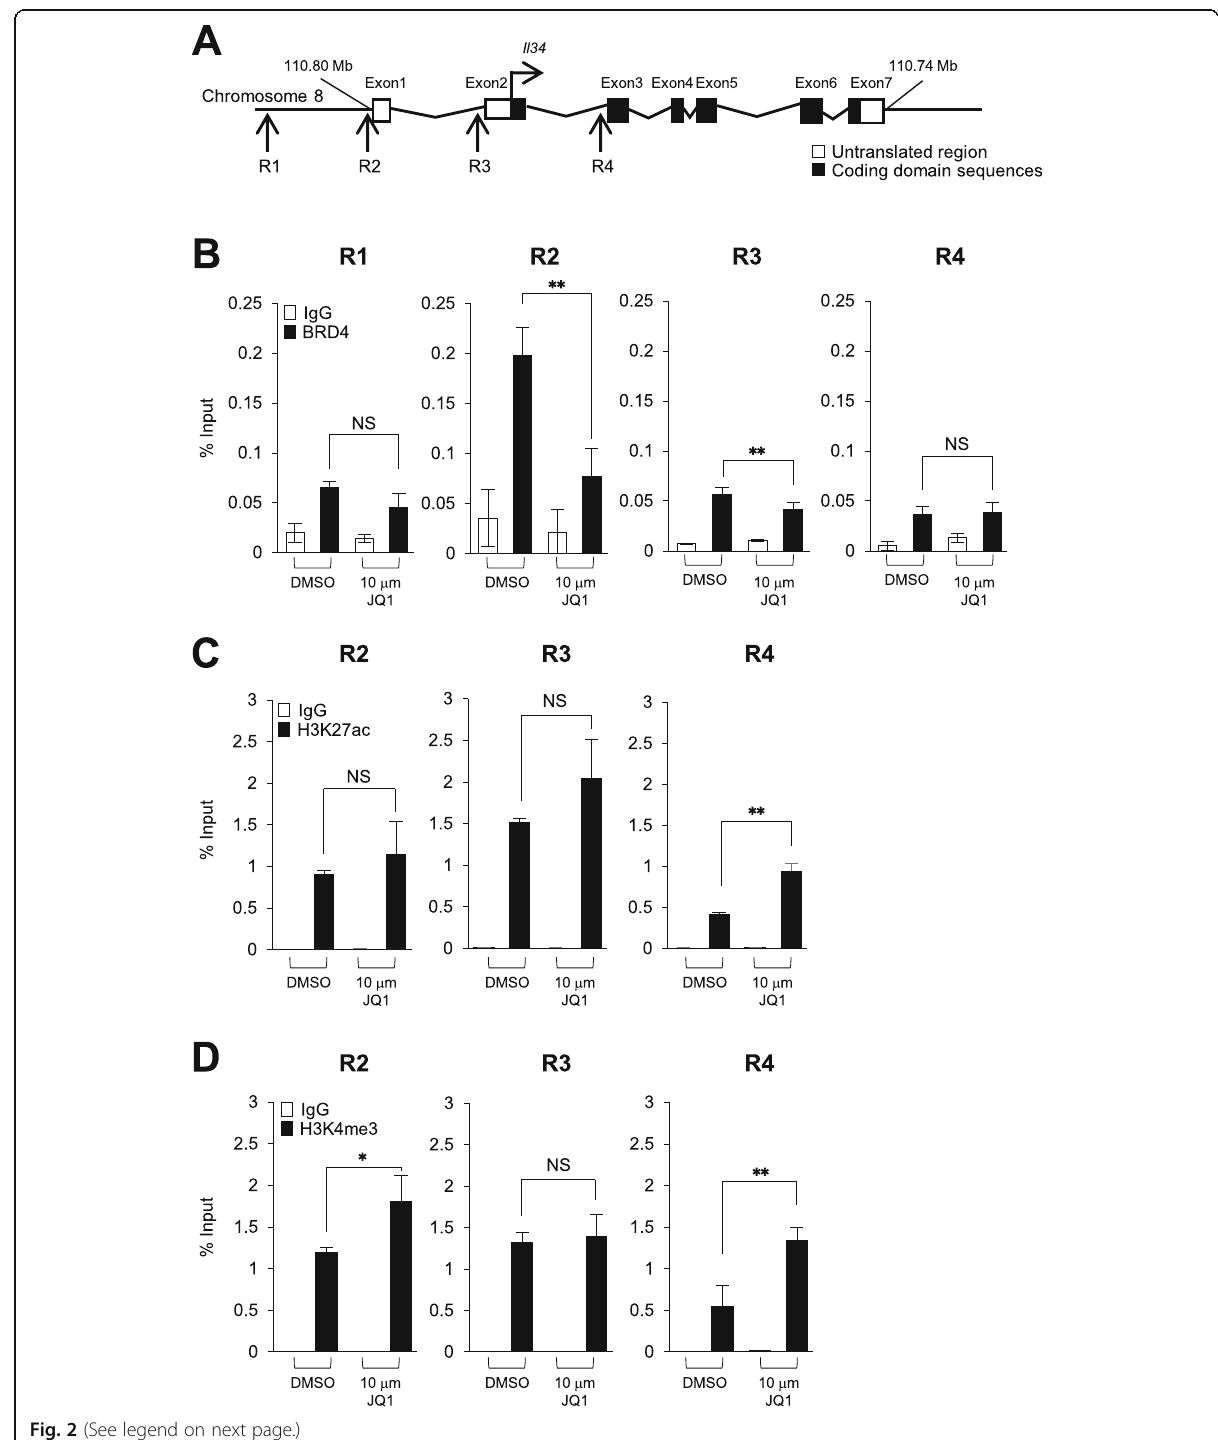
Fig. 2 (See legend on next